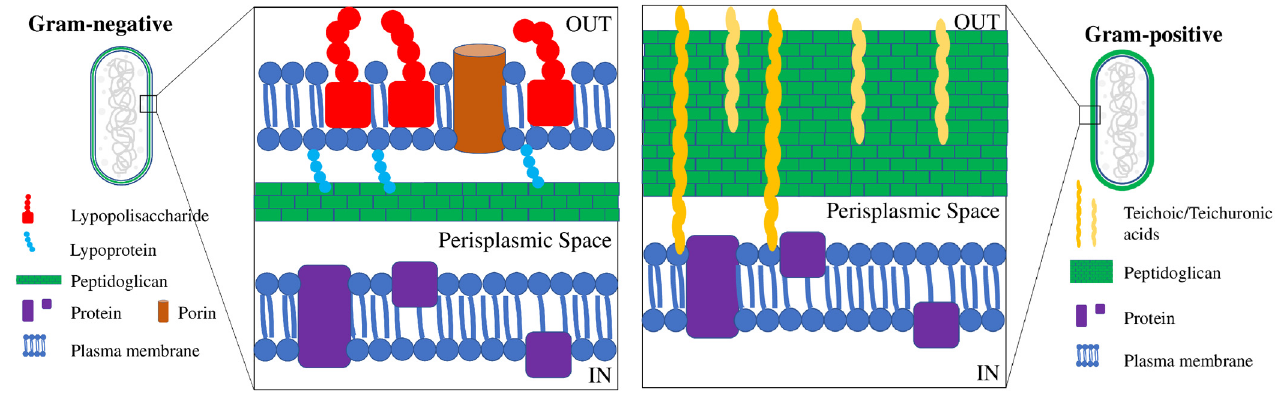
Figure 1. Schematic structure of Gram-negative and Gram-positive cell walls. Gram-negative bacteria have an inner and an outer cell membrane (double lipid bilayer) and only a thin layer of peptidoglycan in the periplasmic space, whereas Gram-positive bacteria show only one lipid plasma membrane and a thick peptidoglycan layer interlinked with teichoic and lipoteichoic